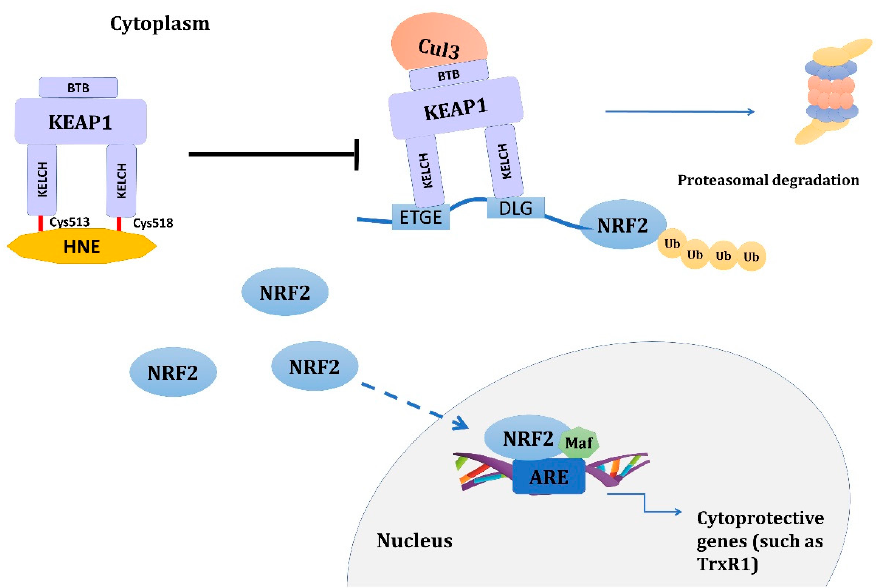
Figure 3. Activation of NRF2 signaling pathway by 4-HNE. 4-HNE adduction of KEAP1 at Cys513 and Cys518 disrupts the binding of NRF2 to KEAP1 and subsequent proteasomal degradation of NRF2. Instead, accumulated cytoplasmatic NRF2 translocates to the nucleus, initiating the